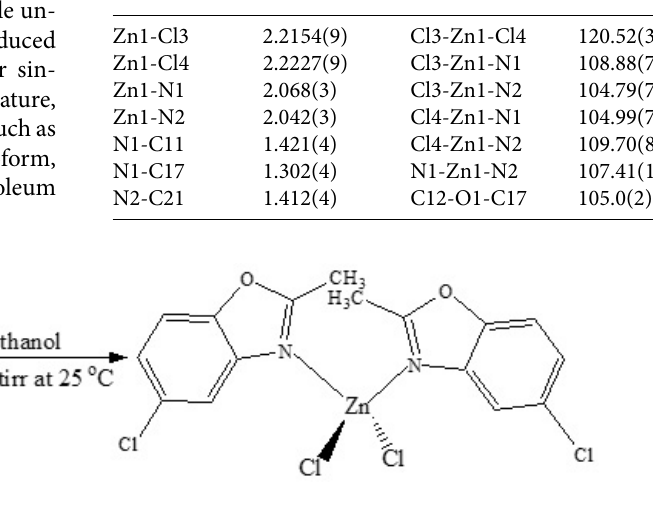
Table 2. Selected bond distances (Å) and bond angles (°) of the